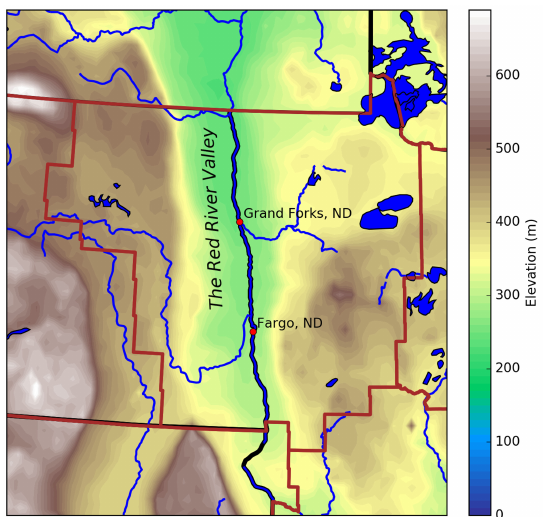
Figure 1. Topography of the Red River Valley (RRV) of the North. Elevation (ASL) is shaded while National Weather Service (NWS) County Warning Areas (CWAs) are denoted by the dark red polygons. Larger water bodies and rivers are highlighted in blue.